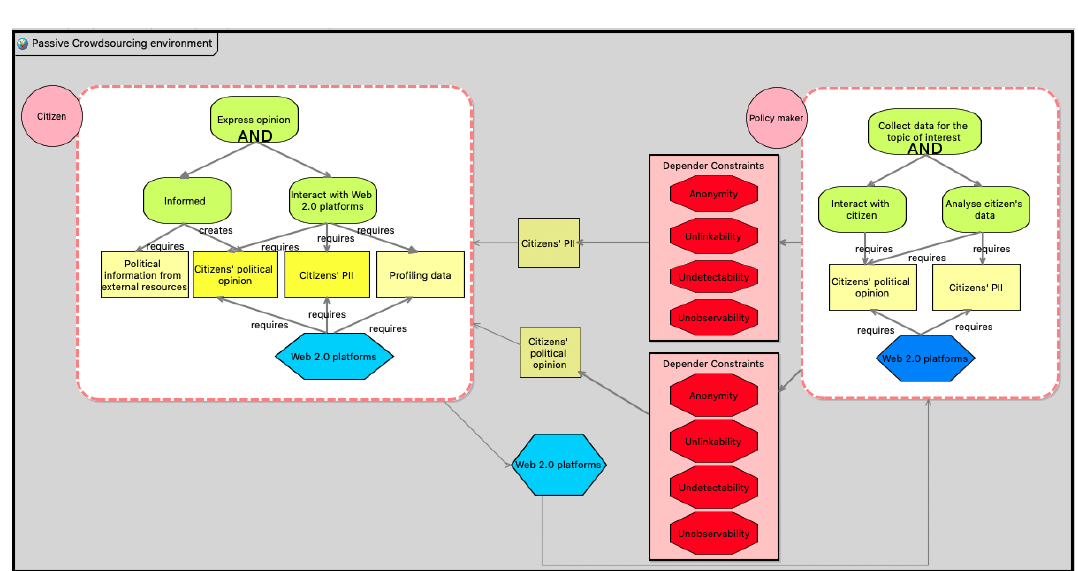
Figure 3. Passive Crowdsourcing environment analysis—privacy